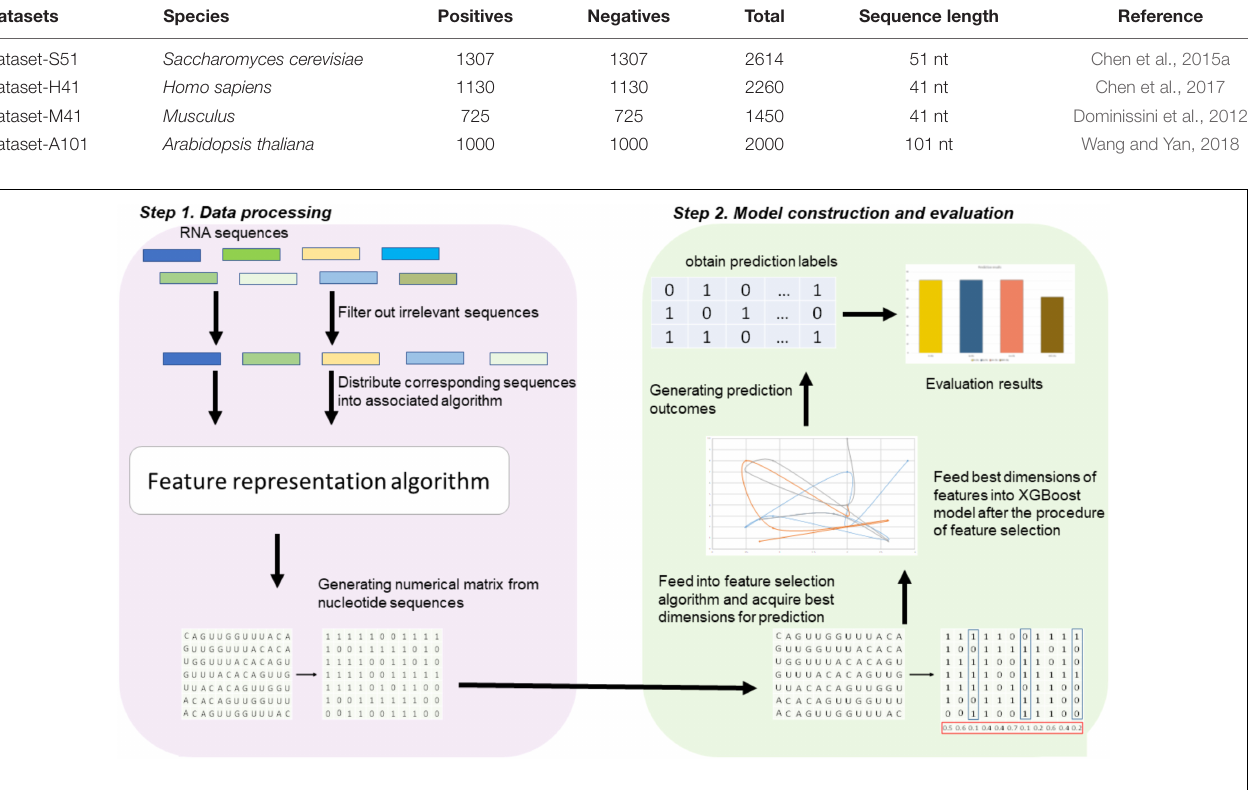
(0,0,0,1); AC is encoded as (0,0,1,0); and so forth, GG is